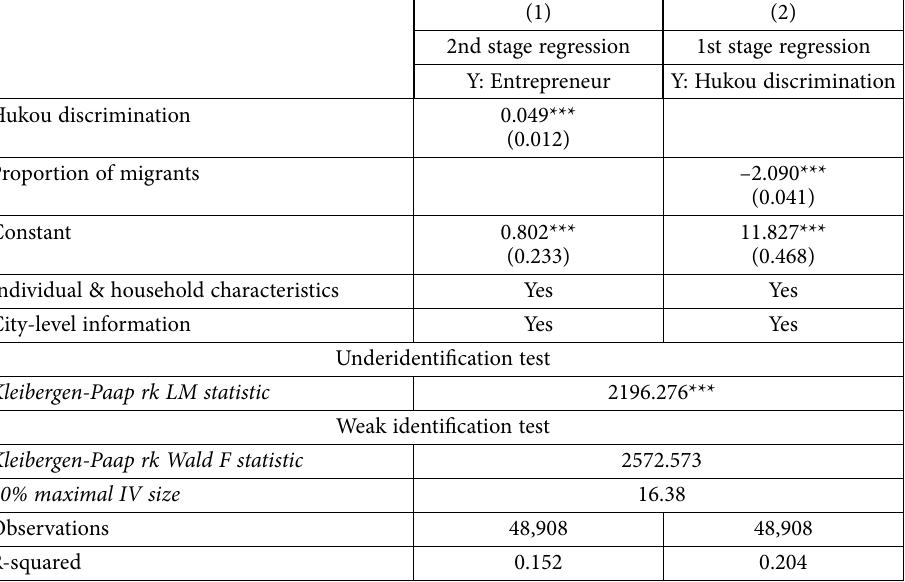
Table 6. Hukou discrimination and entrepreneurship: 2SLS (sample of rural migrants)